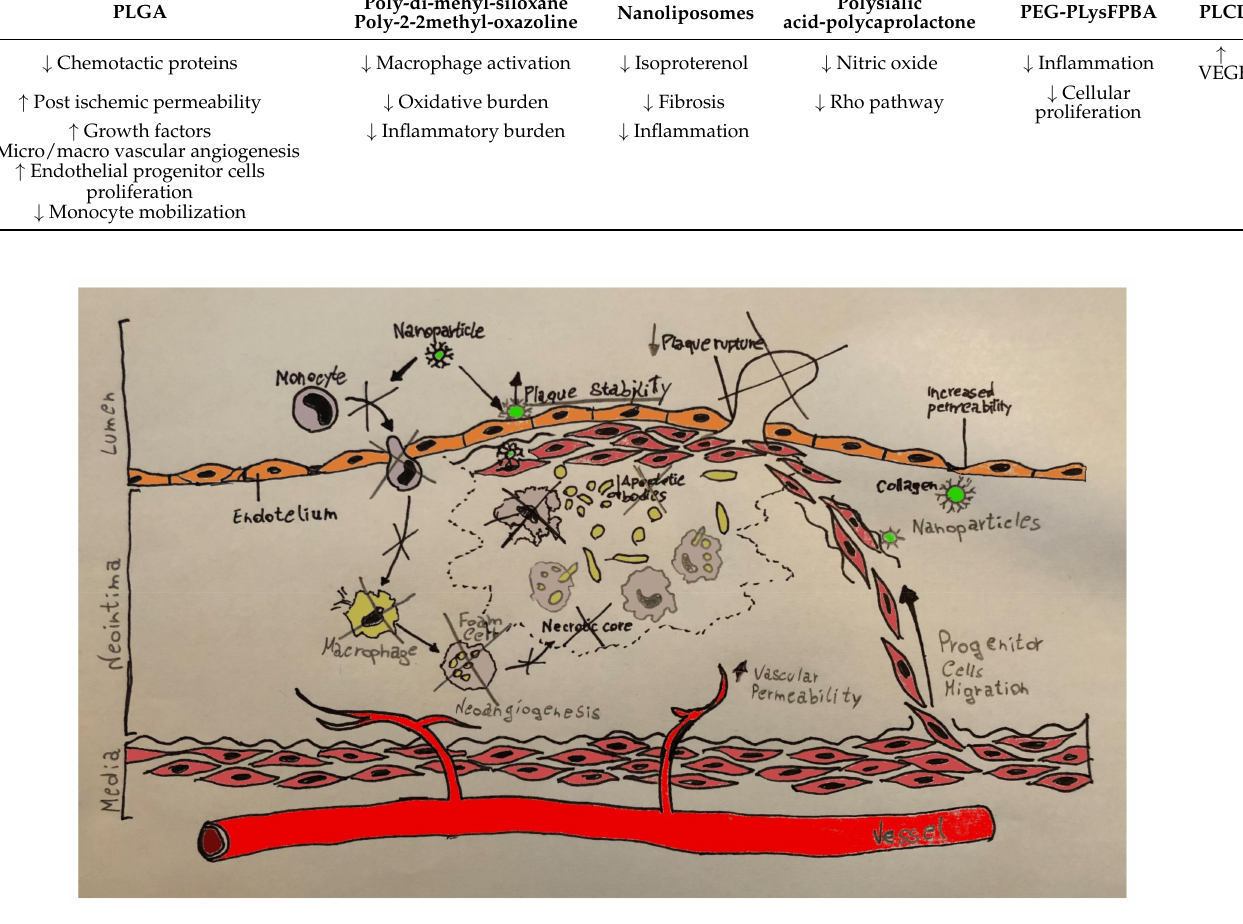
Figure 3. Poly-lactic-co-glycolic acid (PLGA) effects on atherosclerotic plaque and ischemic myocardium. PLGA promotes myocardial regeneration, plaque stability and reduces post-ischemia-reperfusion injury through different pathways. It inhibits the expression of chemoreceptor proteins and inhibits monocytes recruitment to prevent destabilization and rupture of the atherosclerotic plaque. By stimulating neoangiogenesis and increasing vascular permeability in tissues injured by ischemia it protects the tissue from damage from revascularization and myocardial fibrosis while preserving ejection fraction. By stimulating the production of tissue growth factors, it promotes cell migration of progenitor cells by promoting myocardial regeneration. By inhibiting the recruitment of monocytes from the bone marrow, it protects the myocardial extracellular matrix from postischemic